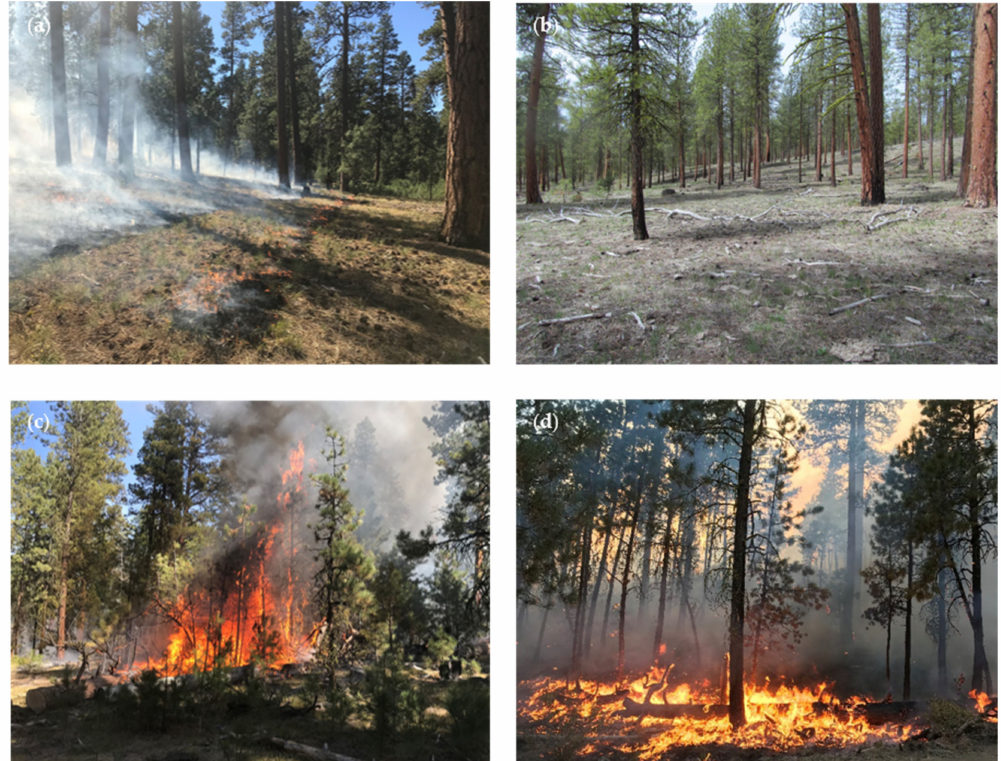
Figure 5. Photos of prescribed burning and vegetation response of study experimental units on the Malheur National Forest, Oregon USA: ( a ) Example from more mesic Trout experimental unit of multi-strip ignition with drip torches designed for combustion of surface fuels and low flame lengths; ( b ) More eastern and xeric Driveway fall 5 year plot unit in 2013 with fairly homogenous surface fuels, understory vegetation, and overstory canopy conditions; ( c ) Fall 2018 prescribed burn in Trout experimental unit with more active fire behavior, resulting in torching of smaller tree patches; ( d ) Fall 2018 prescribed burn in Trout experimental unit with more intense fire and combustion of heavier